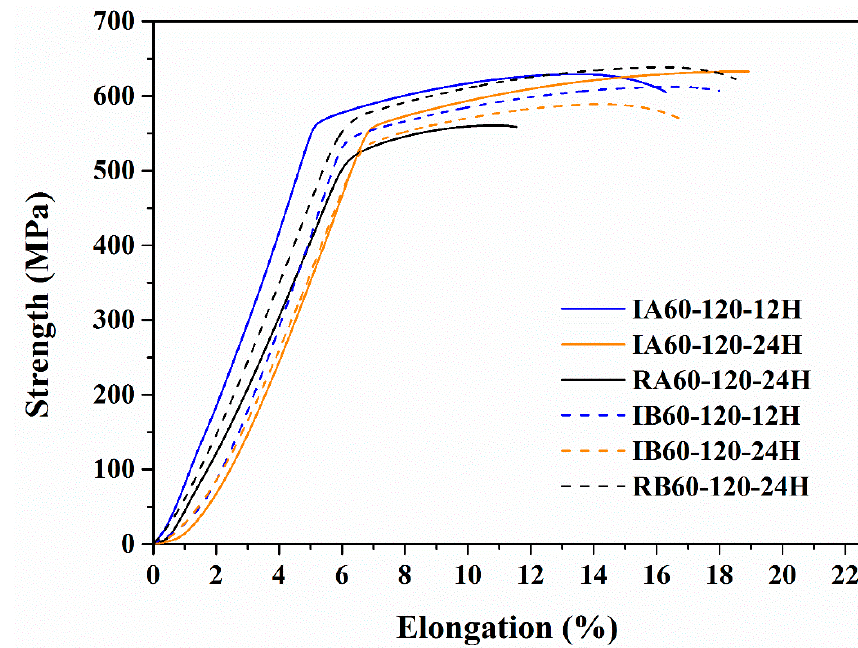
Figure 10. Tensile strength curves of various specimens.